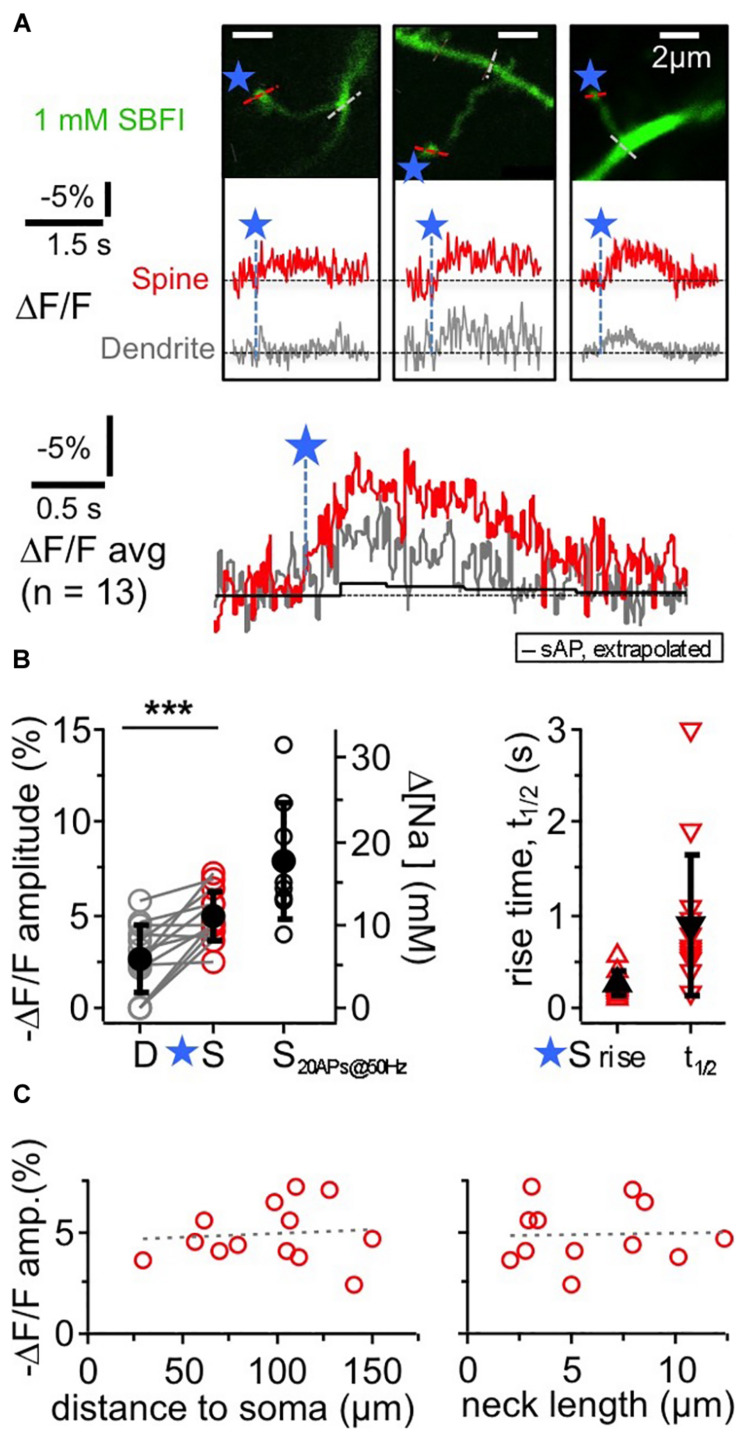
TPU-evoked Na+ entry into juvenile rat GC spines. Imaging of TPU-evoked Na+ transients within GC spines with low exogenous buffering (1 mM SBFI). Experimental setup as in Figure 1A. (A) See also Figure 1B. Top: two-photon z-stacks of three representative examples of individual spines filled with SBFI. Blue stars denote uncaging locations. Red and gray dotted line indicate line scan positions for the leftmost spine. Middle: respective averaged fluorescence transients (ΔF/F)TPU within the above spines (S, red) and within the adjacent dendrite (at the base of the spine neck, D, gray). Bottom: (ΔF/F)TPU transients averaged across experiments (n = 13 spines) with the same time axis, spine response in red and dendrite response in gray. Note the similar time course of the dendritic response. Black trace: extrapolated response (ΔF/F)AP to a single backpropragating somatically evoked AP (from mean response to 20 APs at 50 Hz, see (B) Amplitude (ΔF/F)AP ≈ –0.4%, t1/2 ≈ 1.7 s). (B) Cumulative plots. Left panel: (ΔF/F)TPU amplitudes in dendrite and spine pairs (highly significantly different, P < 0.001, Wilcoxon test) and (ΔF/F)50Hz amplitudes in response to a 50 Hz train of 20 APs in a subset of the same spine heads (n = 9). Right axis: changes in [Na+]i concentration (calibration from Ona-Jodar et al., 2017). Right panel: half durations t1/2 of (ΔF/F)TPU within the spine heads (t1/2 could not be measured in most dendritic transients because of noise). (C) (ΔF/F)TPU spine amplitudes vs. distance of the spine to the soma and spine neck length (means 99 ± 35 μm and 5.9 ± 3.3 μm respectively, n = 12). Dashed lines: linear fit. No significant correlations.